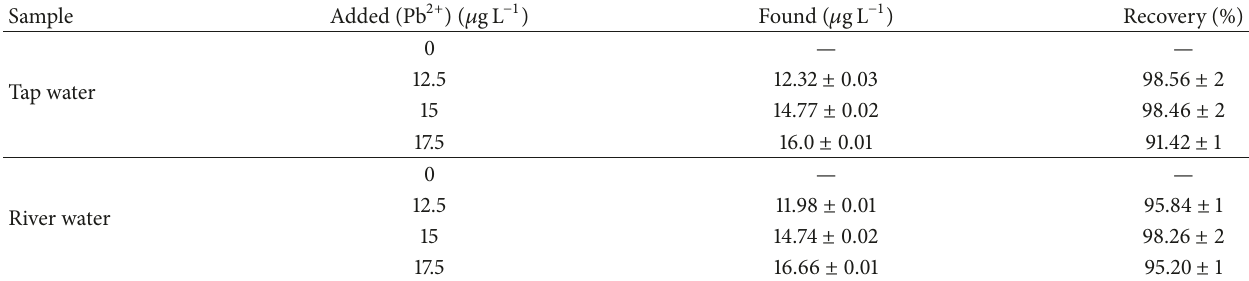
Table 4: Determination of Pb (II) ions in tap-water and river-water samples.